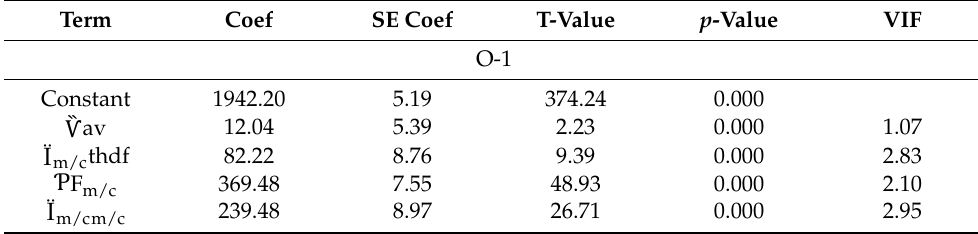
Table 10. Coded regression coefficients for O-1 to